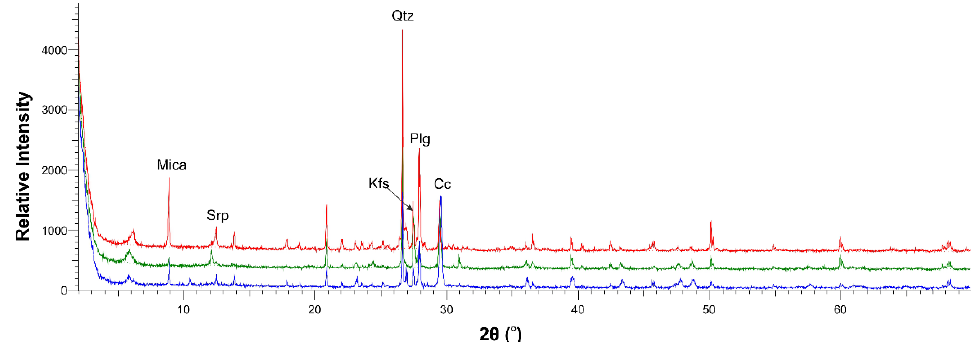
Figure 3. XRD analysis of samples EPN-2B (Northern Eptachori Formation; red-colored), OX-3G (Pentalofos Formation; green-colored), and KAL-3B (Southern Eptachori Formation; blue-colored).